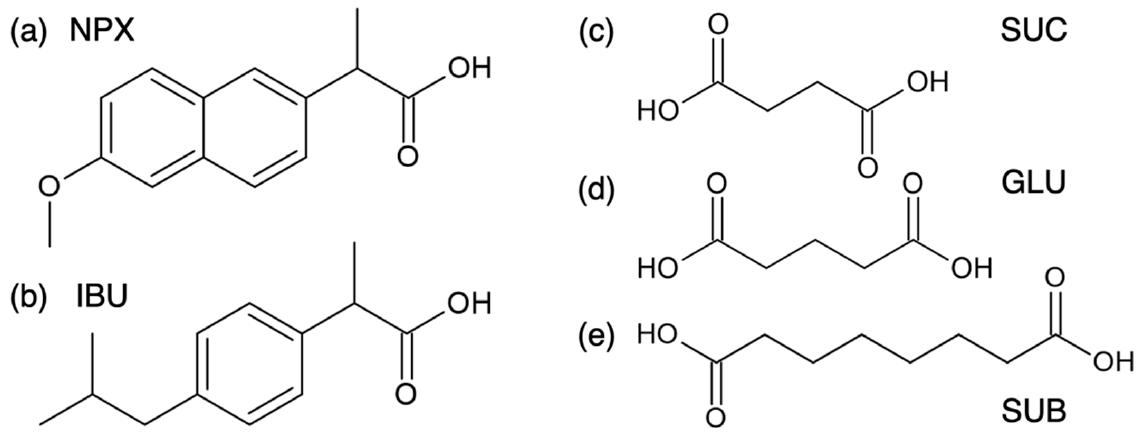
Figure 1. Molecular structures of ( a ) naproxen (NPX), ( b ) ibuprofen (IBU), ( c ) succinic acid (SUC), ( d ) glutaric acid (GLU), and ( e ) suberic acid (SUB).